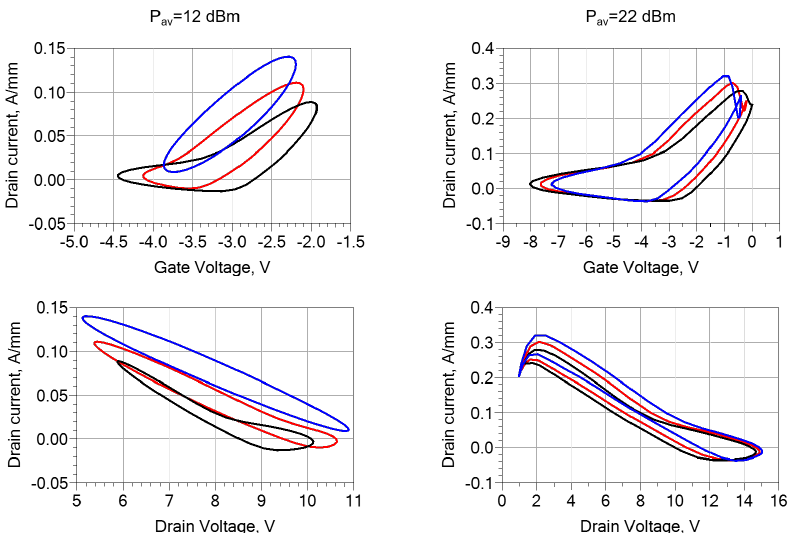
Figure 12. Dynamic load lines of the active device biased in deep class AB with varying doping concentrations in the active channel: nominal doping N D = 2 × 10 17 cm − 3 (red lines), − 10% doping (black lines), and + 10% doping (blue lines) at two input drives.